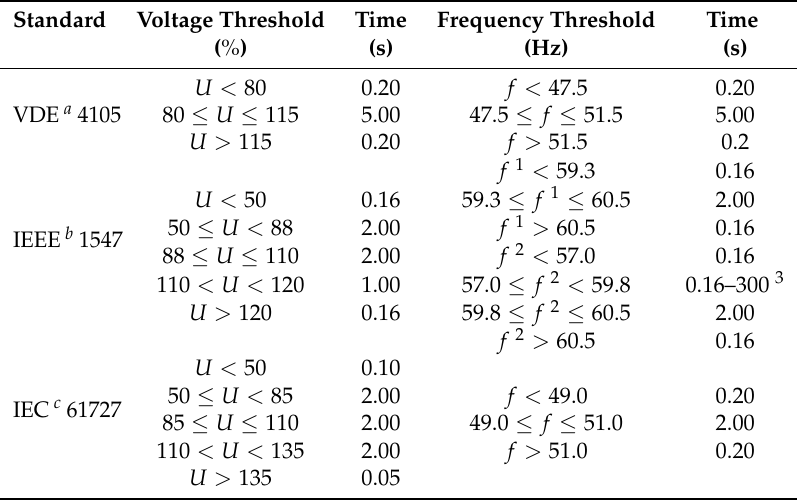
Table 1. Summary of islanding threshold detection